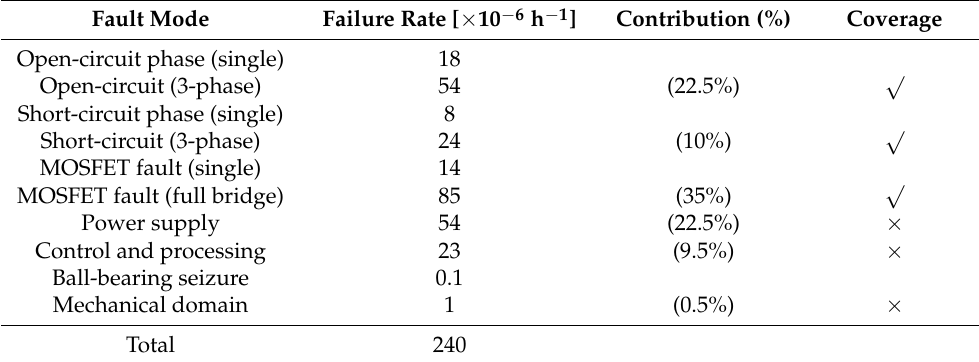
Table 1. Failure rates for PMSM faults